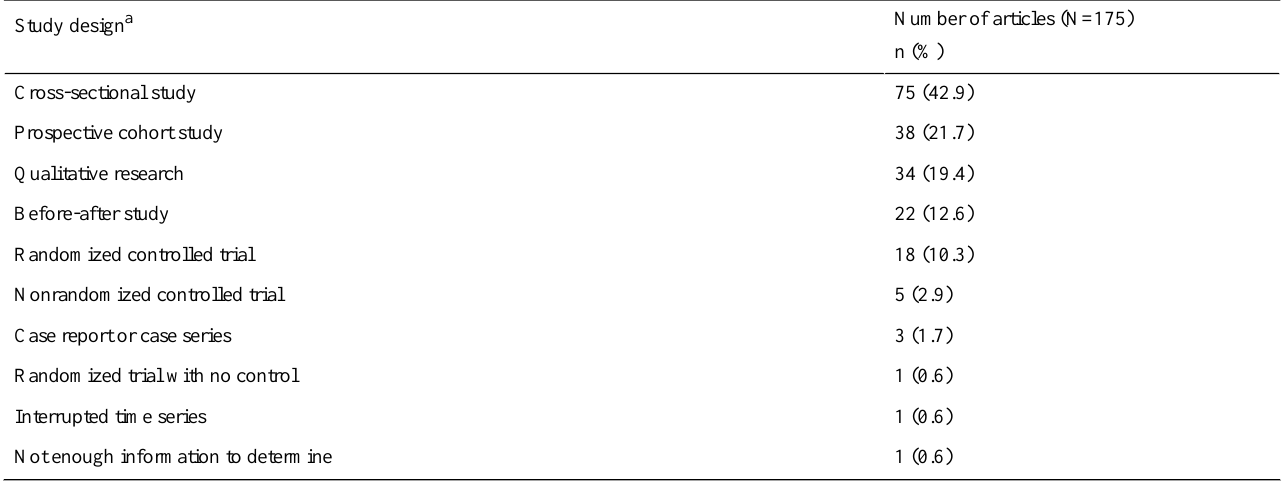
Table 4. Study designs used in abstracted